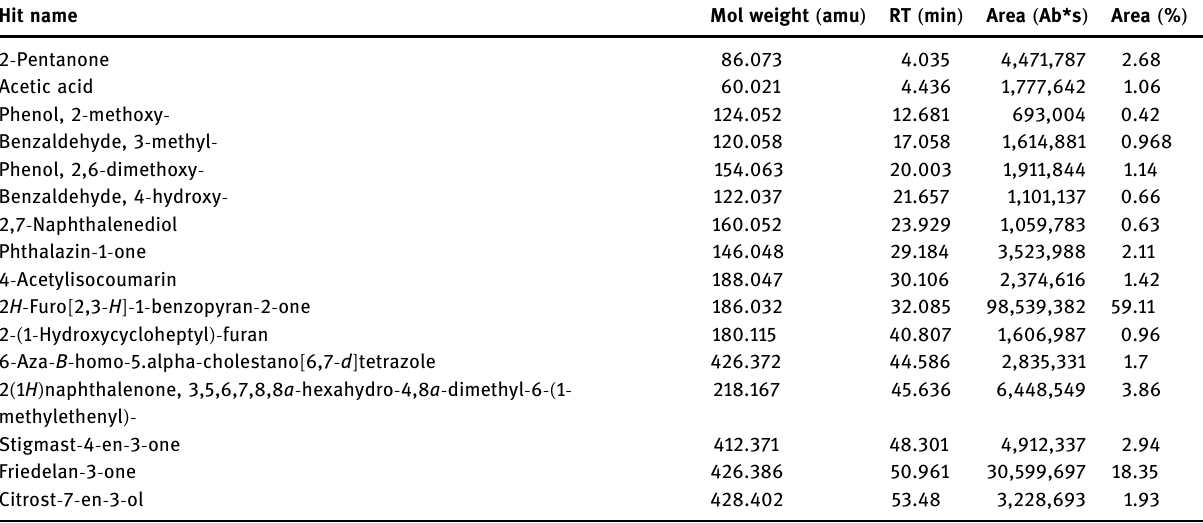
Table 2: GC – MS data of water extract Hit